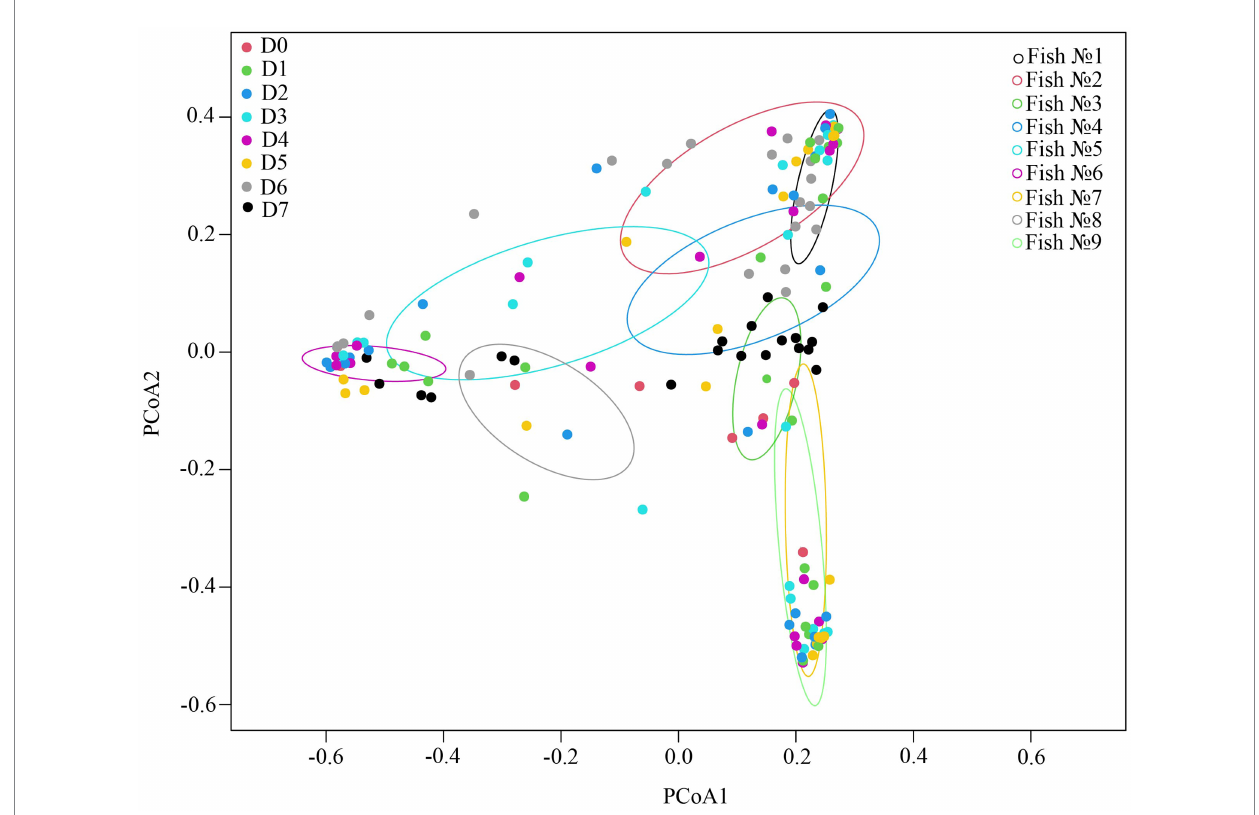
FIGURE 6 Test effect of factor «Fish» on microbial community of cestodes using ADONIS test on Weighted UniFrac